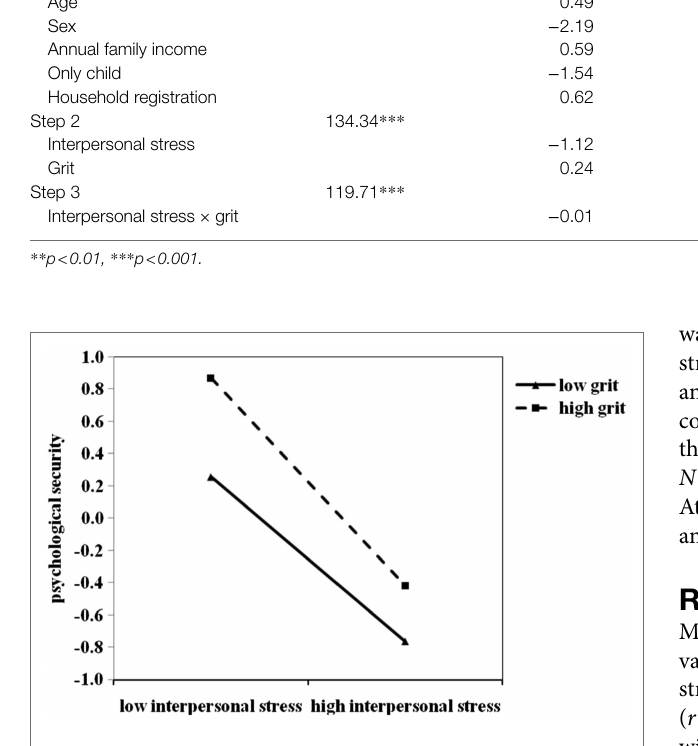
FIGURE 1 | The moderating role of grit on the relationship between Interpersonal stress and Psychological security in Study 1. All the study variables were standardized. High/low level of Interpersonal stress = M ± 1SD. High/low level of grit = M ±